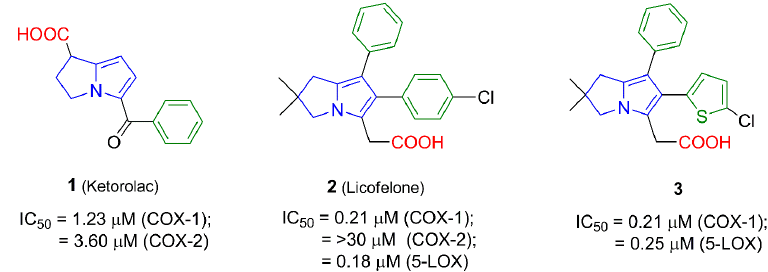
Figure 1. The IC 50 values of pyrrolizine-based anti-inflammatory agents 1 – 3 linked with a carboxylic acid moiety.